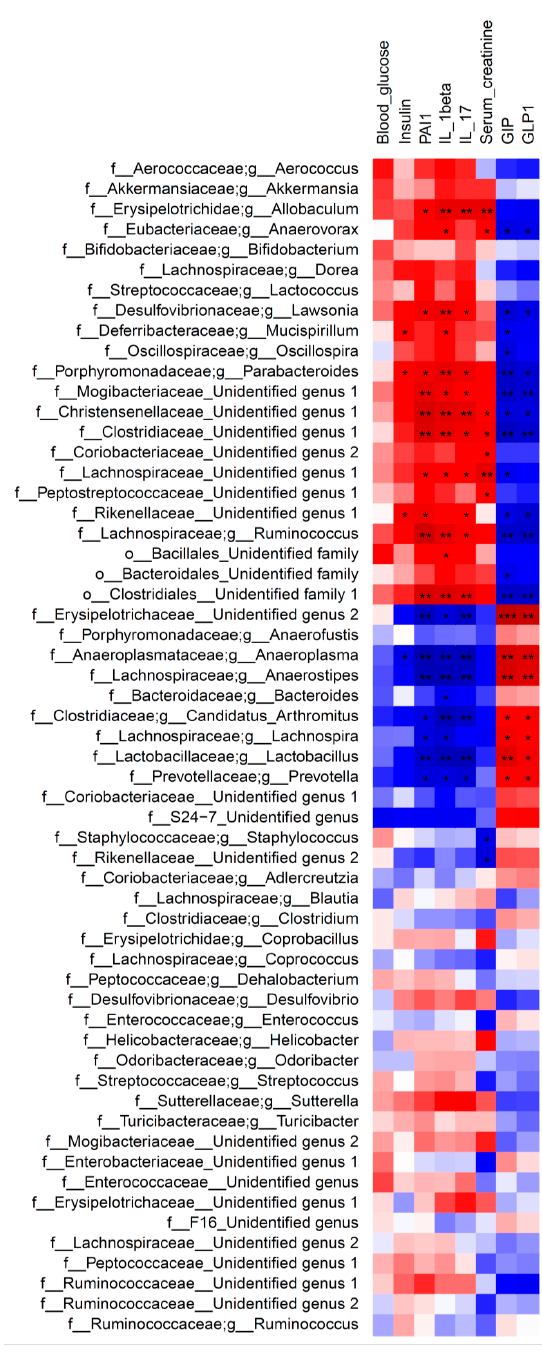
Figure 7. Heatmap of Spearman’s correlation between the fecal bacteria genera and systemic measurements in CD and AGE-D groups. Dark red indicates positive correlation, while dark blue represents negative correlation. Statistical significance: * p < 0.05, ** p < 0.01. Genera and families were reported as “Unidentified” when they could not be assigned to any genera / family within a given family / order at a percentage sequence homology of 95% and 90%, respectively, to existing genera and families in the reference database (http: //